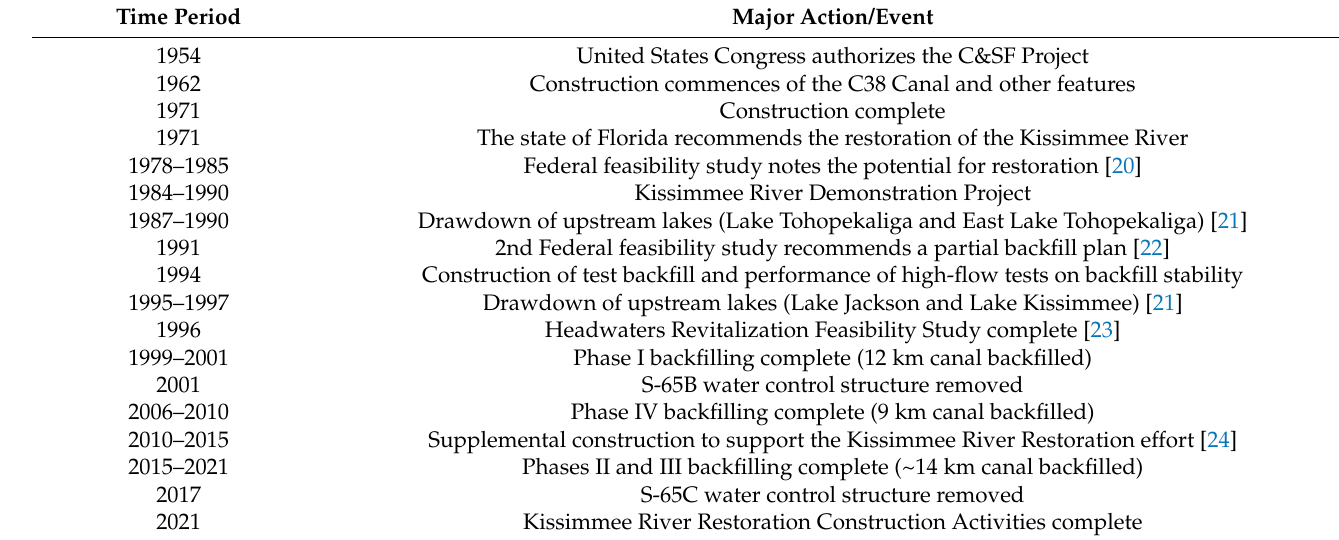
Table 1. Major Actions and events related to the Kissimmee River Restoration Project and regional water